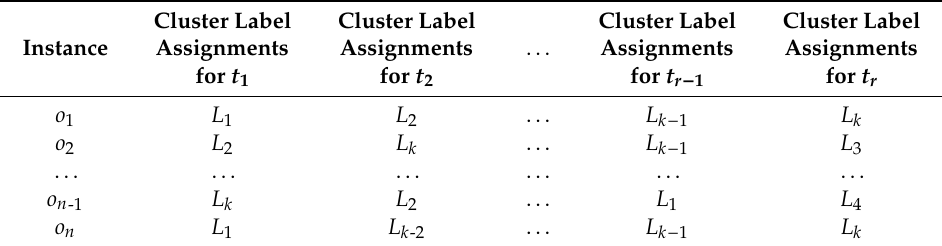
Table 3. Assignments of cluster labels under di ff erent